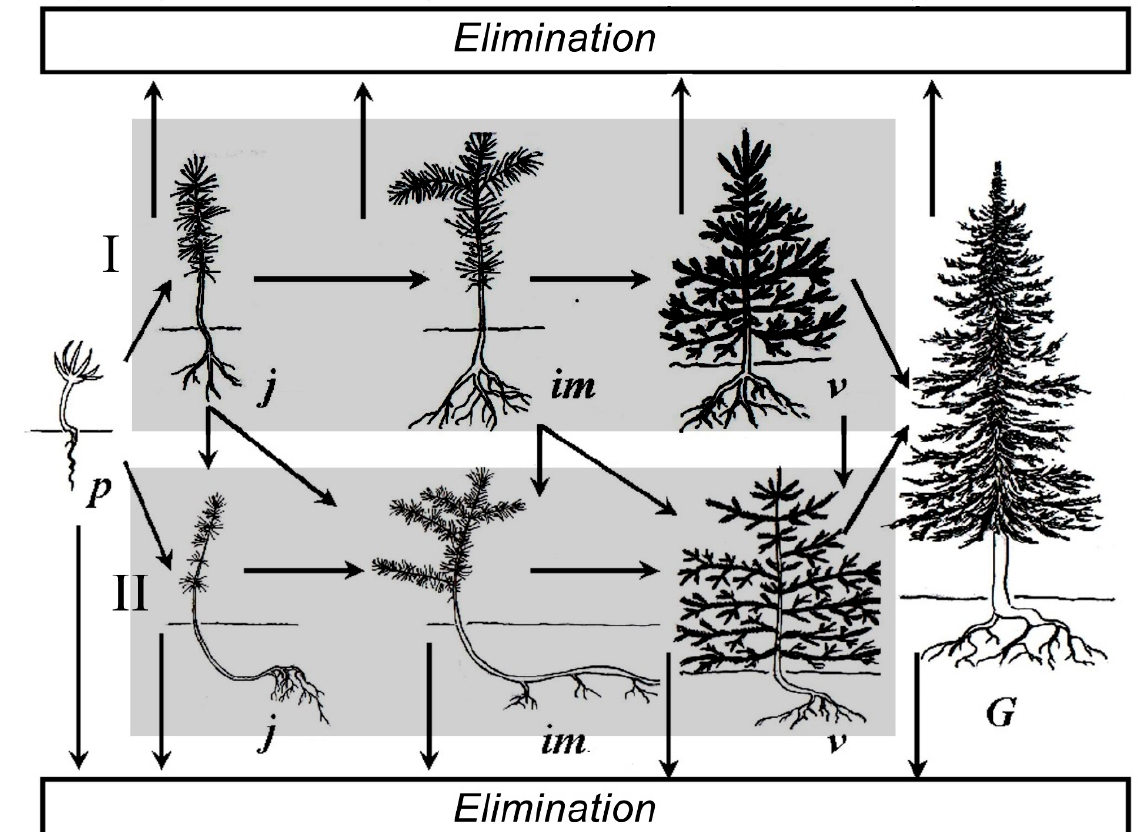
Figure 3. Scheme of the ontogeny of the Siberian spruce ( Picea obovata Ledeb.). Ways of development: I—in supportive environments (“direct” path); II—in adverse environments (“waiting” mode). Ontogeny states: p = pre-juvenile (seedlings), j = juvenile; im = immature; v = virginile; G = generative. The arrows indicate possible transitions. When the environment does not allow spruce to grow along the direct path,